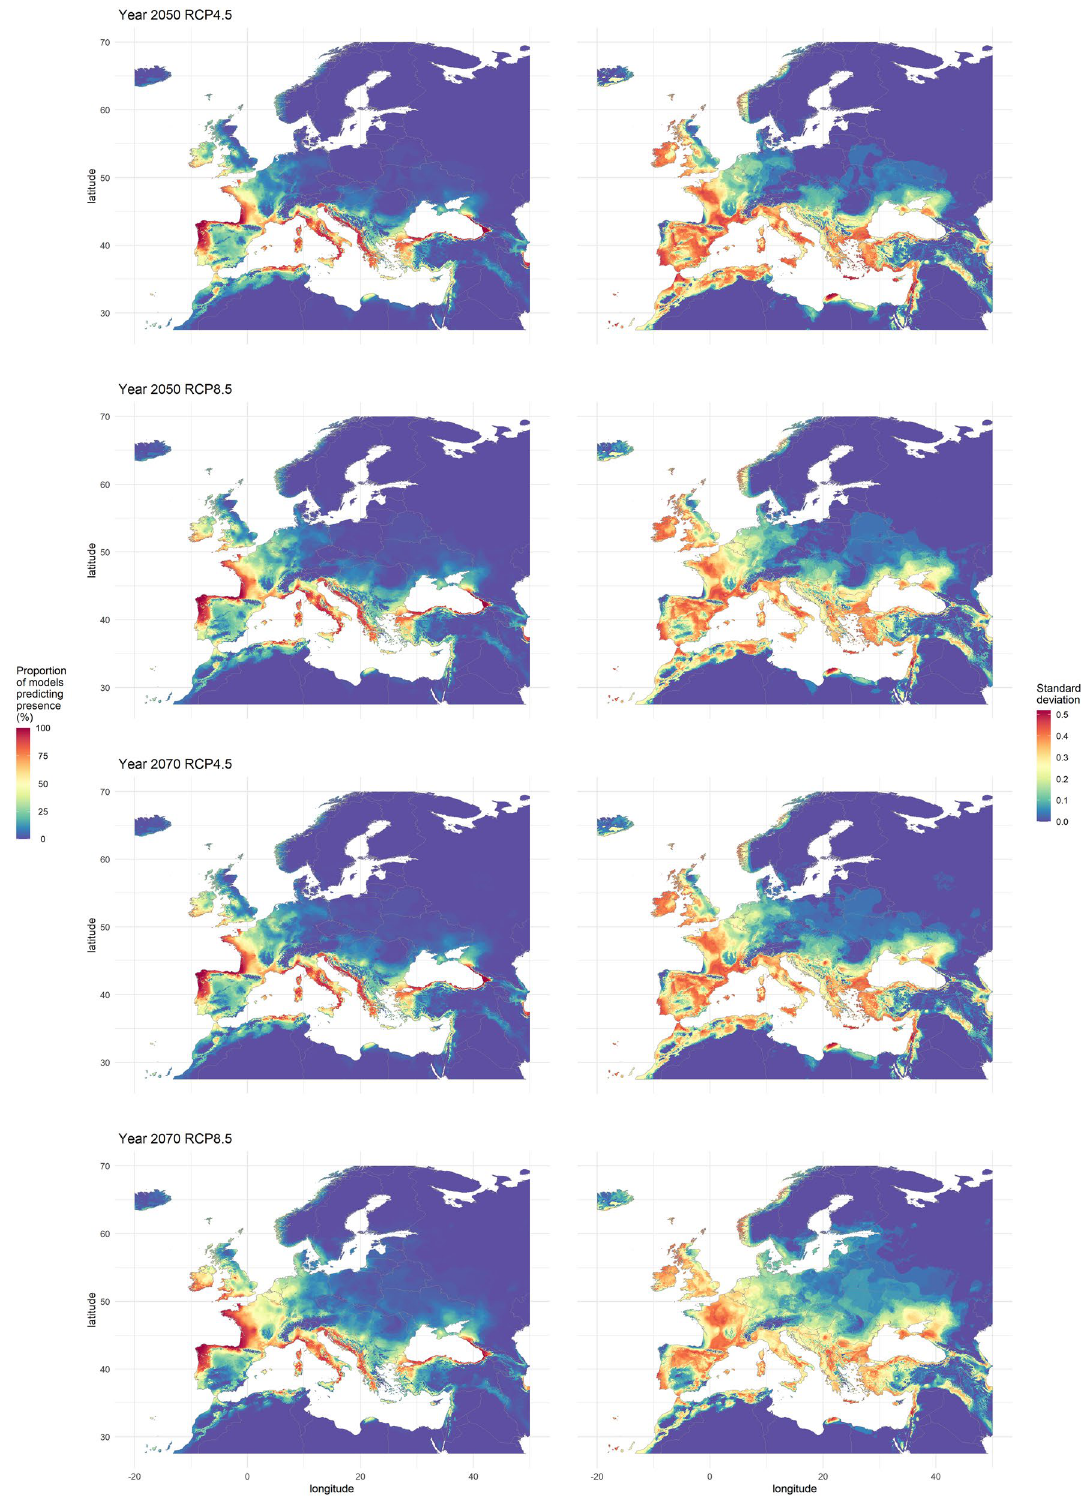
Figure 3. On the left side, consensus maps showing habitat suitability for Xylosandrus compactus under future climate for 2 greenhouse gases concentration scenarios (RCP4.5 and 8.5) and for 2 years (2050 and 2070). These consensus maps were computed by averaging presence–absence maps and represent the percentage of models predicting each pixel as suitable. On the right side, maps representing the standard deviation of their left counterpart where the higher values the lower the agreement between models’ predictions. The maps were generated using R 4.0.0 (https ://cran.r-proje